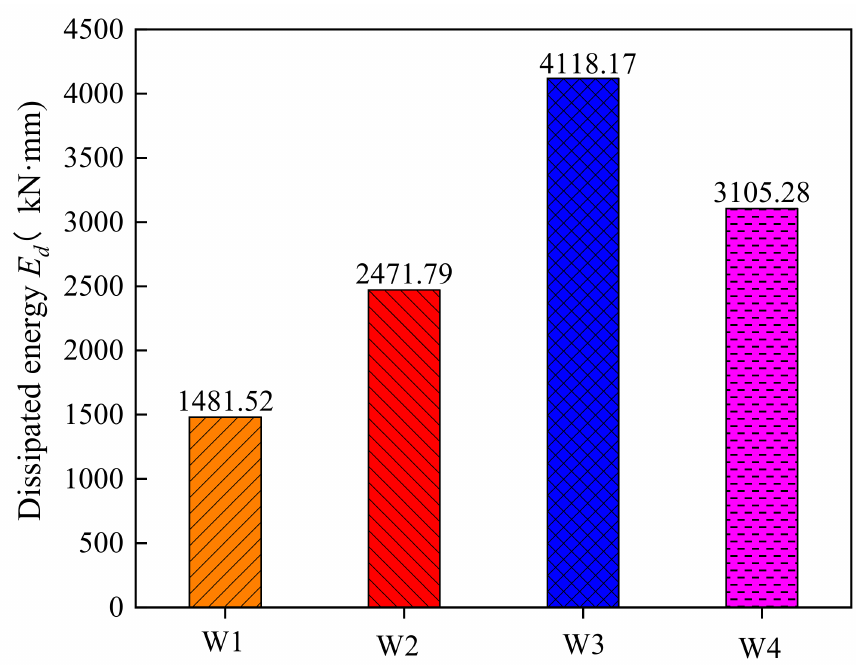
Figure 12. Energy dissipation of